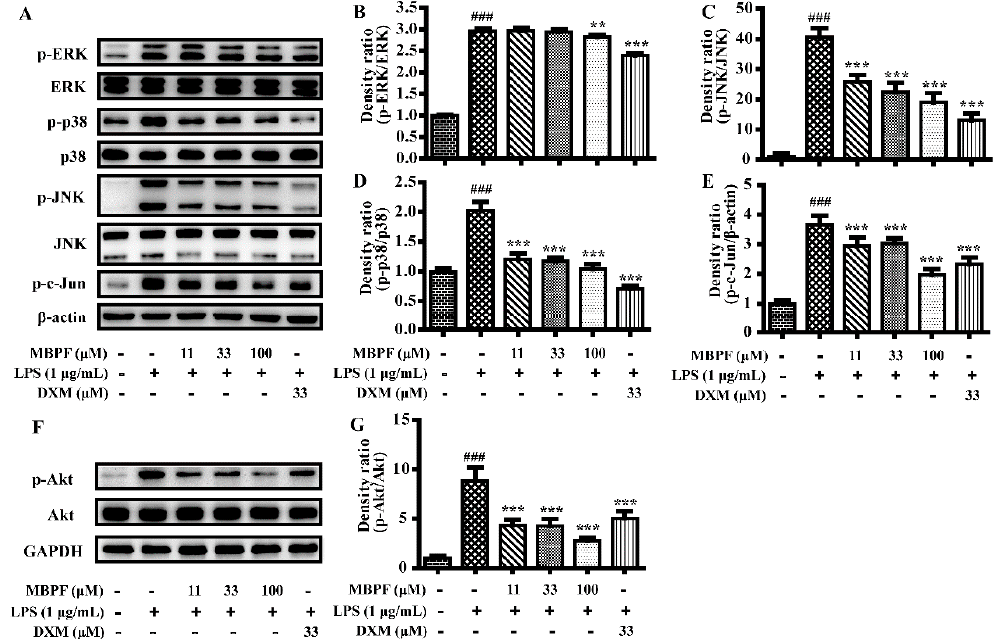
Figure 6. Effects of MBPF on MAPK and the PI3K/Akt signaling pathway in LPS-induced RAW 264.7 cells. The cells were pretreated with different concentrations of MBPF (0, 11, 33, and 100 μ M) for 2 h and were then stimulated with or without LPS (1 μ g/mL) for 30 min. The protein levels of phospho- extracellular regulated kinases (ERK1/2/ERK1/2), phospho-p38/p38, phospho-c-Jun N-terminal kinases (JNK/JNK), and phospho-c-Jun/ β -actin were analyzed using Western blot ( A – E ). The p-Akt/Akt proteins were also determined using Western blot (( F ) and ( G )). Data represent the mean ± SE from three separate experiments. ( ### p < 0.001 vs . control group; ** p < 0.01, *** p < 0.001 vs . LPS group).